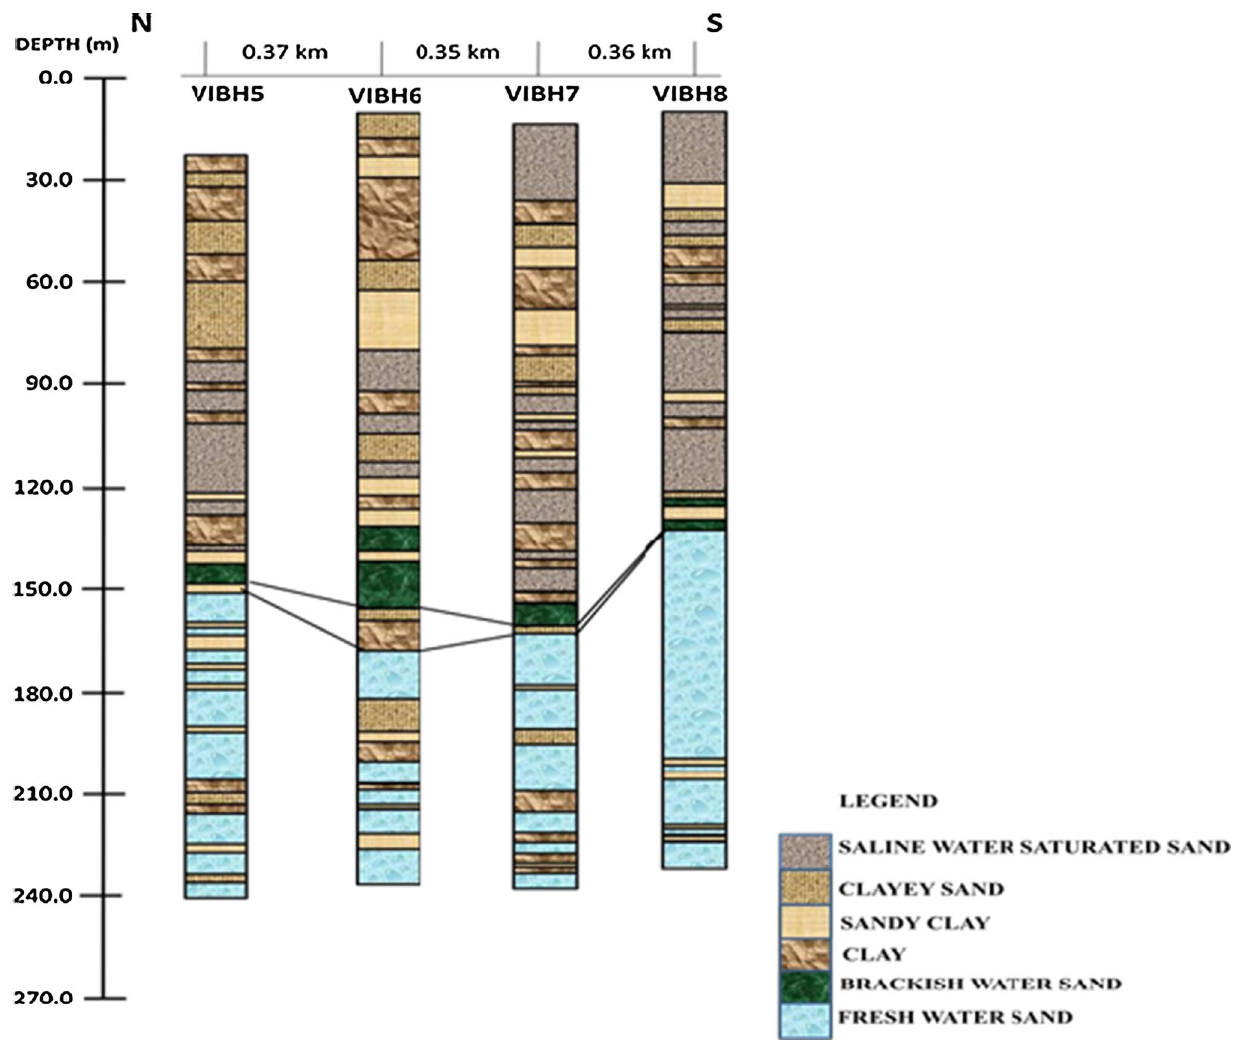
Fig. 5 Correlation panel of geosection B–B ′ showing the occurrence of the end of polluted sand unit and the beginning of freshwater sand